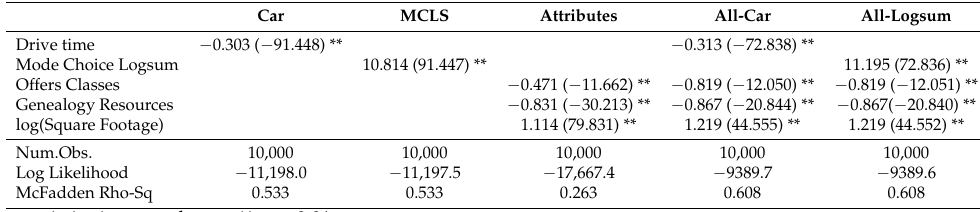
Table 4. Library Destination Choice